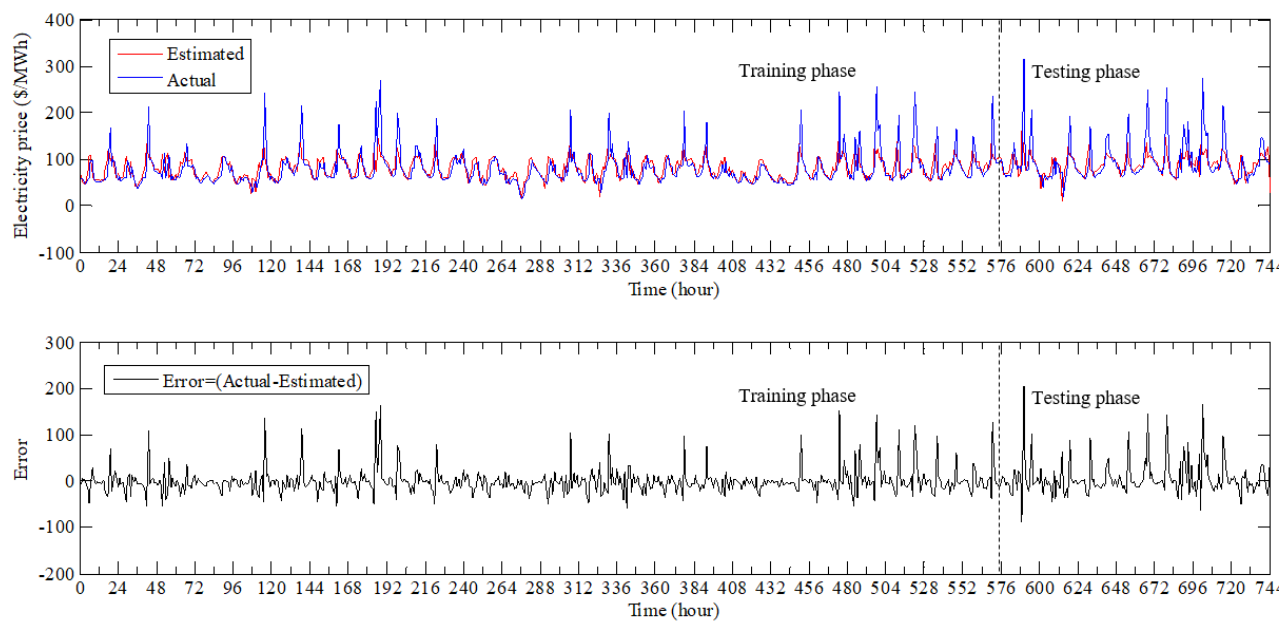
Figure 6. The evaluation of the performance throughout training at the designing and testing phases of ANFIS-BSA and its corresponding error of EPF in May 2018 for QLD.